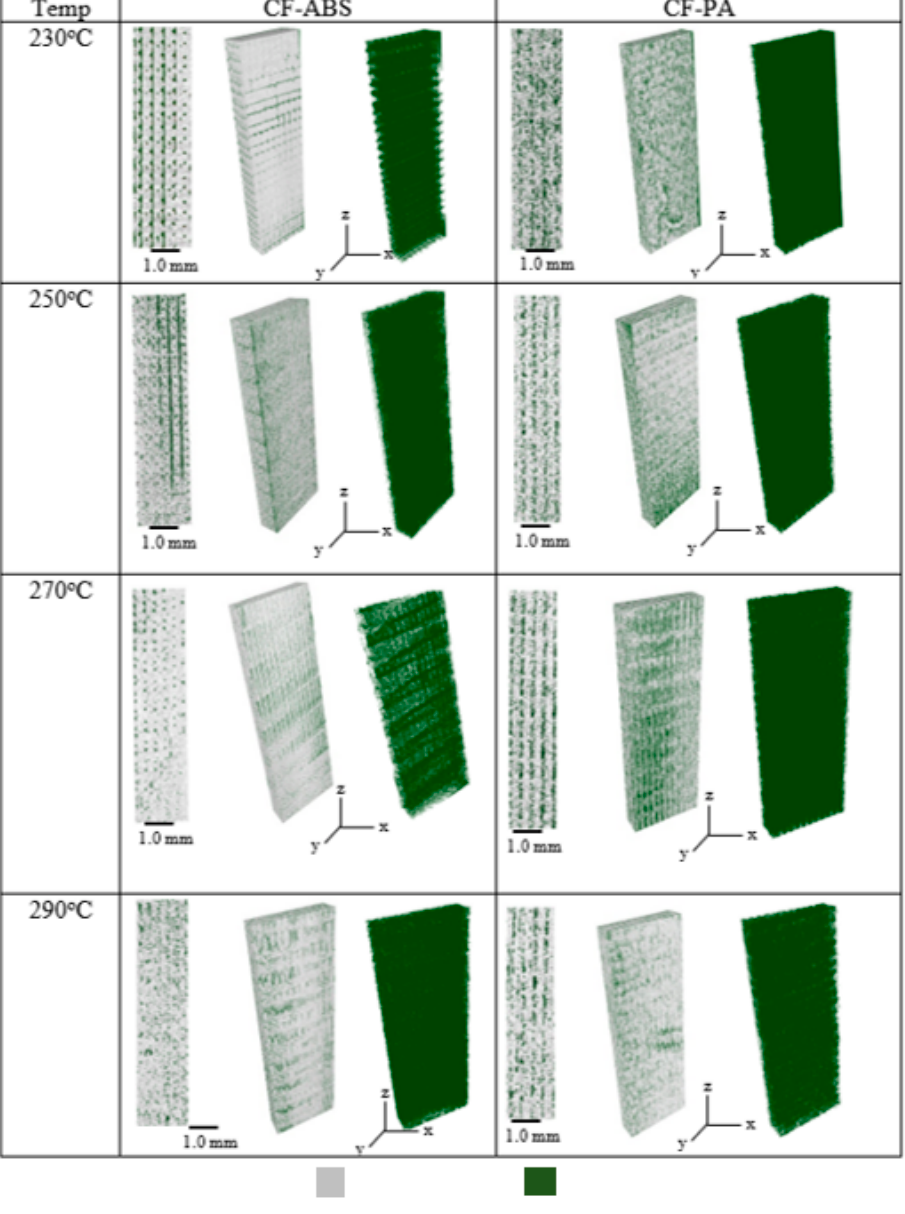
Figure 6. Reconstructed X-ray CT void for CF-ABS and CF-PA composite specimens for the different fabrication temperatures under study.